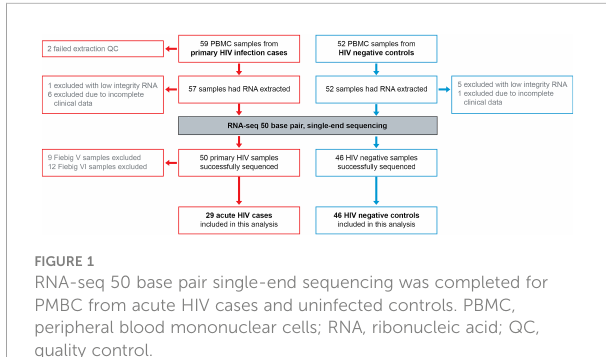
FIGURE 1 RNA-seq 50 base pair single-end sequencing was completed for PMBC from acute HIV cases and uninfected controls. PBMC, peripheral blood mononuclear cells; RNA, ribonucleic acid; QC, quality